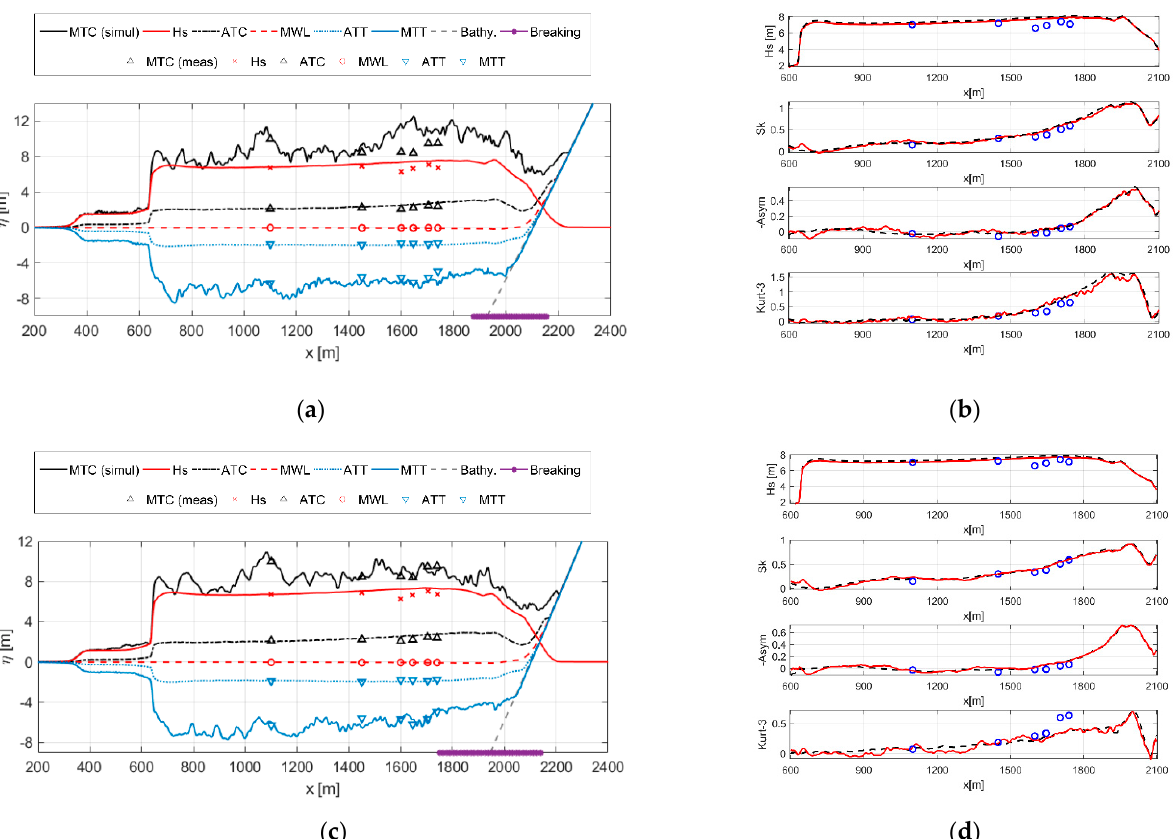
Figure A1. Wave print and statistical quantities over the area for wave case H7.5T16 for two simulation settings: ( a , b ) for simulation without bottom friction and U/C = 0.8, and ( c , d ) for U/C = 0.5, without bottom friction.